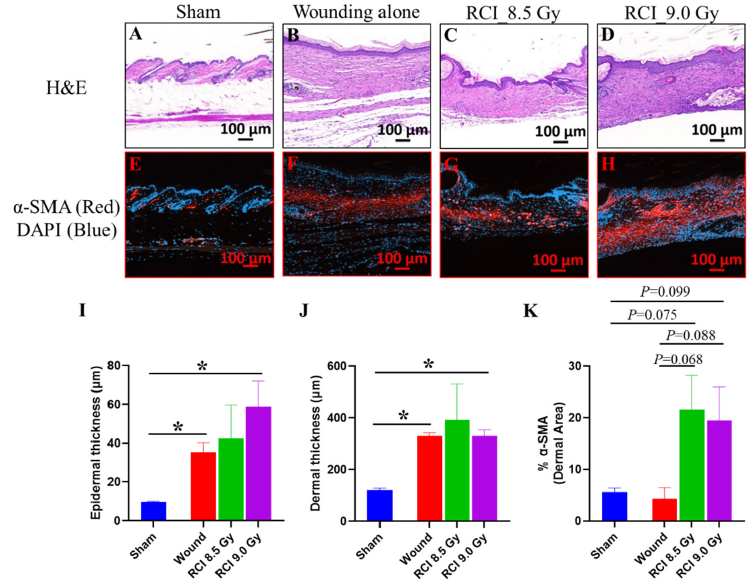
Figure 7. Histological and immunohistochemical (IHC) evaluation of skin wounds to assess the ep- idermal and dermal responses after SW alone or 8.5 Gy/9.0 Gy RCI. ( A – H ) Representative images of histological sections of skin wound scar day 30 after TBI stained with hematoxylin and eosin (H&E) ( A – D ). ( E – H ) Representative images of IHC-stained skin wound scar sections for alpha- smooth muscle actin ( α -SMA, a marker of myofibroblast, red) and nuclei (4 ′ , 6-diamidino-2-phenyl- indole, DAPI, nuclear DNA, blue). Scale bar: 100 µm. ( I – K ) Quantification of epidermis thickness (µm), dermis thickness (µm), and dermal α -SMA positive area (%). * p < 0.05, wound or RCI vs. sham by unpaired t-test (two-tailed); N = 3/group. Figure 8. TBI perturbs collagen deposition during wound healing. Collagen morphology/organiza- tion in scars of skin wounds was evaluated by Masson’s trichrome staining (Blue: collagen; Red: cytoplasm; Black: nuclei). ( A – D ) Representative images of histological sections of skin wound scar day 30 after TBI (low magnification) from sham, SW alone, RCI at 8.5 Gy, and RCI at 9.0 Gy groups, N = 3, scale bar: 200 µm. ( E – H ) High magnification images of respective insets displayed in ( A – D ), N = 3/group, scale bar: 50 µm. 4. Discussion The results from the current study demonstrated, for the first time, that the delayed wound closure in RCI mice is not specifically dependent on the extent of hematopoietic